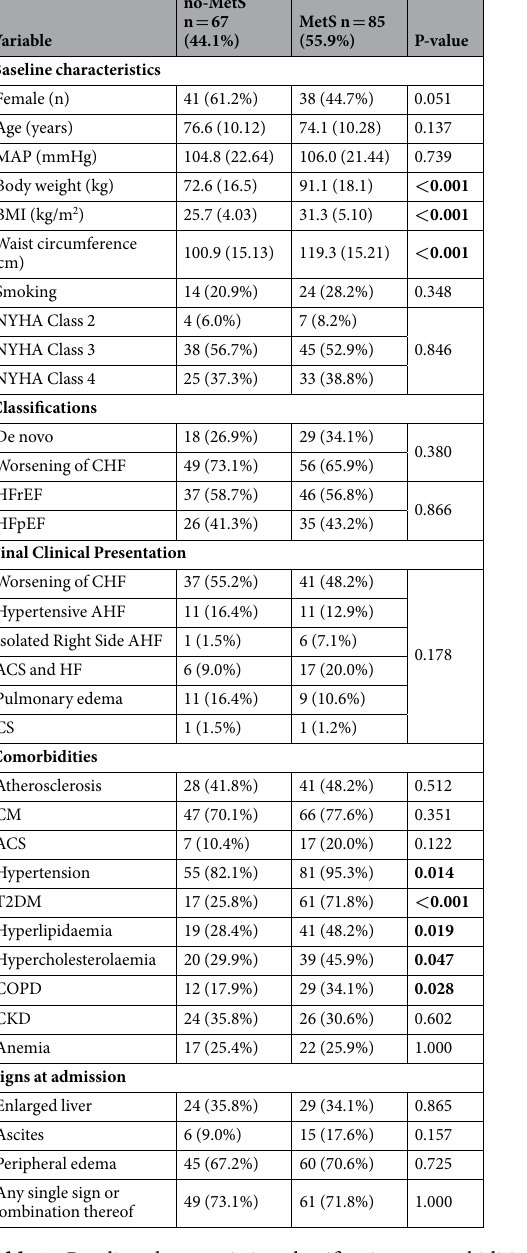
interaction but rather a concomitant regulation of EL- and HDL- levels into the same direction by the underlying AHF pathophysiology. Indeed, the levels of EL, HDL-cholesterol, THDL-p and SHDL-p, but not LHDL-p, were decreased by venous volume overload in the no-MetS group, in which the levels of SHDL-p were slightly affected by HF severity (Supplementary Table S2). However, partial correlation analyses revealed only a weak overall impact of venous volume overload (Supplementary Table S3) and HF severity (Supplementary Table S4) on the correlation between EL- and lipid/lipoprotein plasma levels in the no-MetS group. Observed positive correlation between EL and SHDL-p plasma levels, but no correlation with LHDL-p levels and HDL-s in the no-MetS group